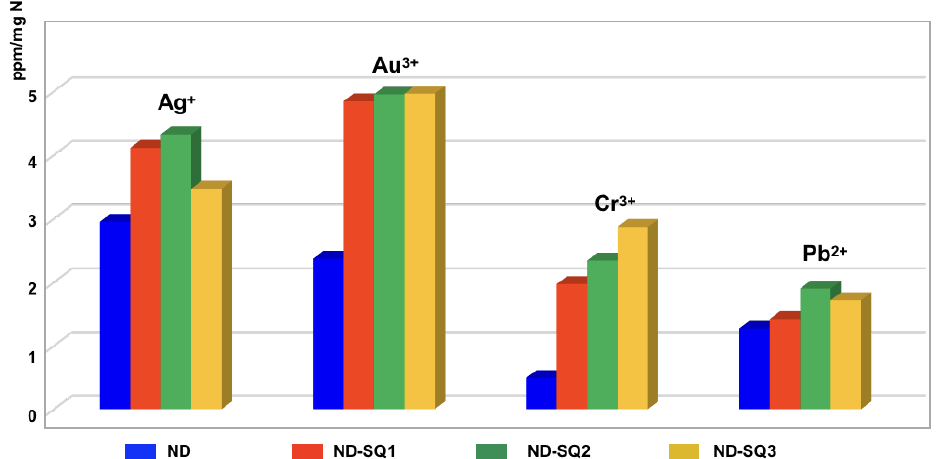
Figure 7. Retention of metal cations by the non-functionalized ND, ND-SQ1, ND-SQ2, and ND-SQ3.